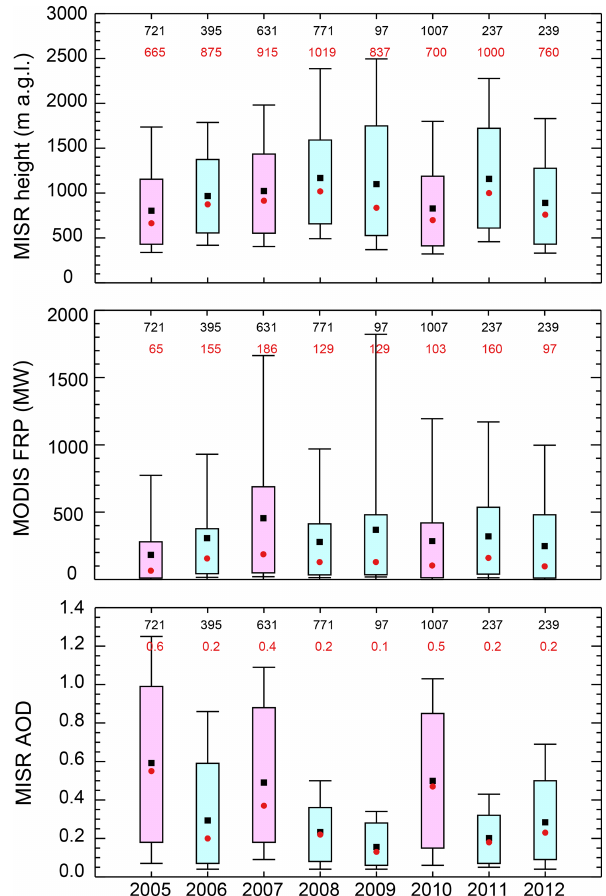
Figure 7. Interannual variability of MISR maximum plume heights above the terrain, MODIS FRP and MISR AOD, for the aggregate of tropical forest, savanna and grassland. Bar plots indicate the dis- tribution of the data for each year. The medians (red circles) and the means (black squares) are shown along with the central 67% (box) and the central 90% (thin black whiskers). The number of obser- vations (in black) and the median values (in red) included in each distribution are given at the top of the plot. Drought years are in pink and non-drought years are in light blue. The same data, stratified by biome type, are plotted in Fig. S4 in the